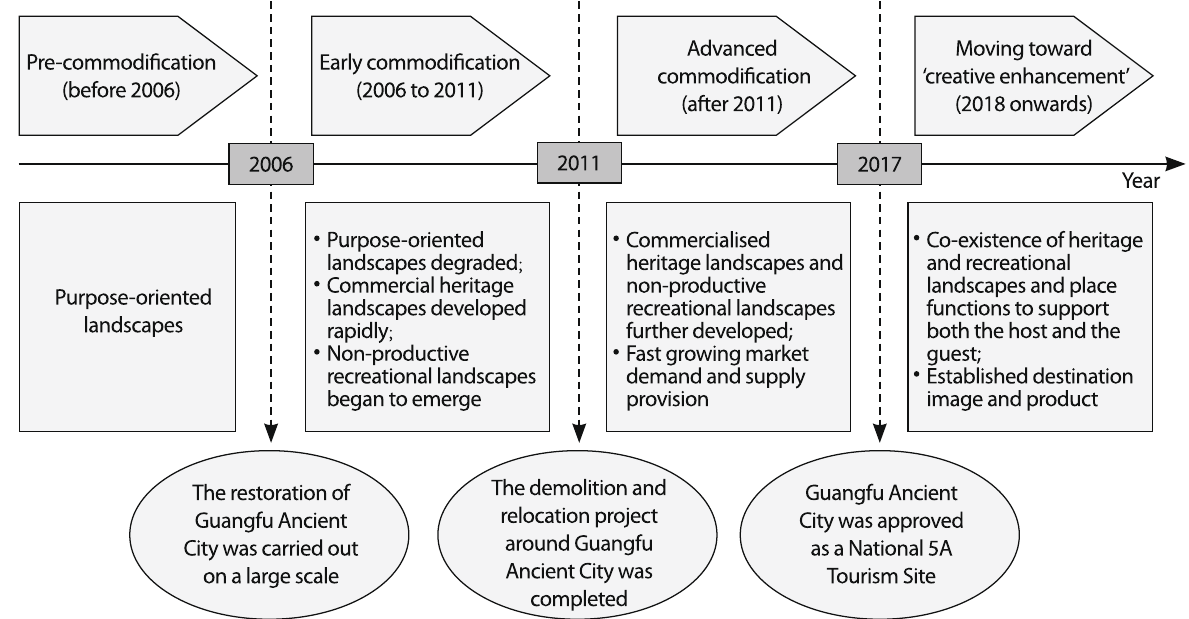
Fig. 7 Heritage tourism development stages of Guangfu Ancient City (Source: the